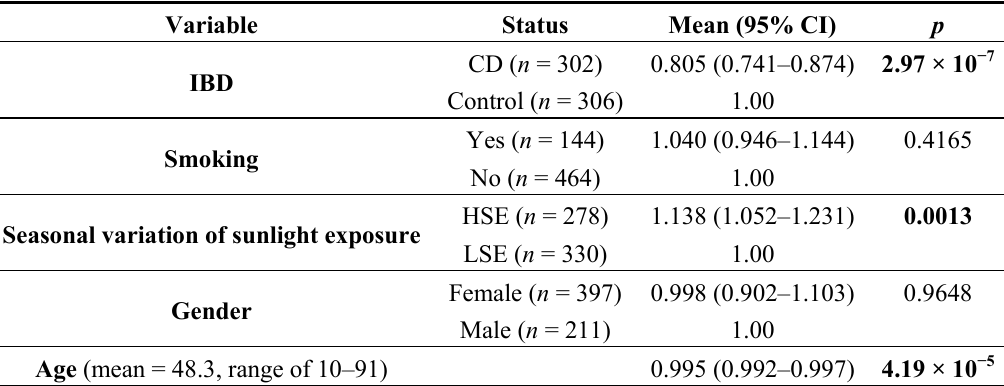
Table 1. Multivariate analysis on serum vitamin